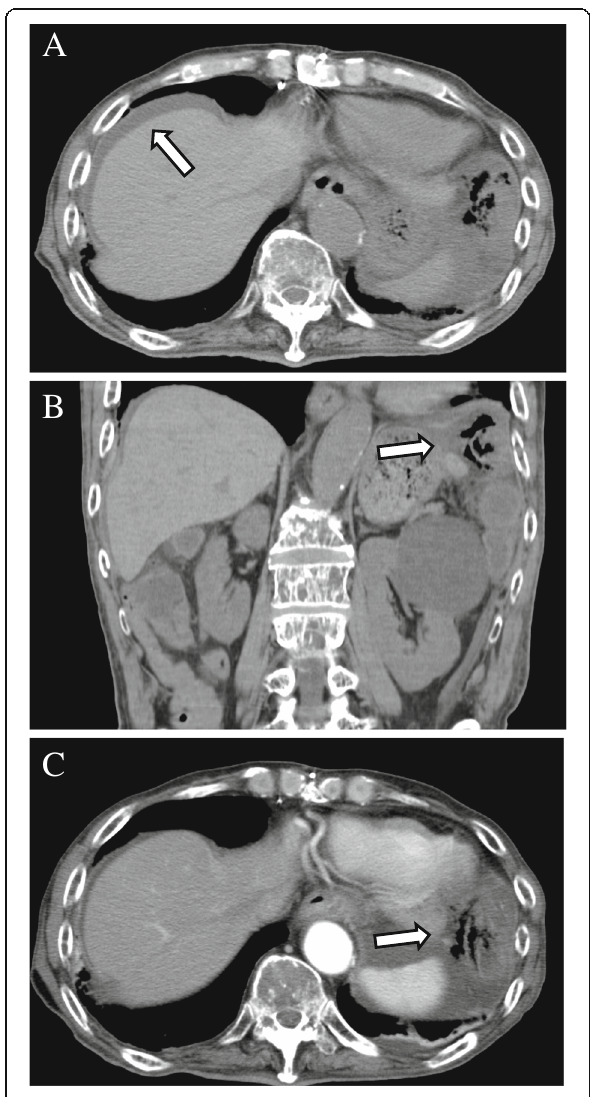
Fig. 1 Abdominal computed tomography (CT). a Ascites around the liver (arrow). b , c Thickness in bowel wall and involving the free air around the colonic splenic flexure (arrow)